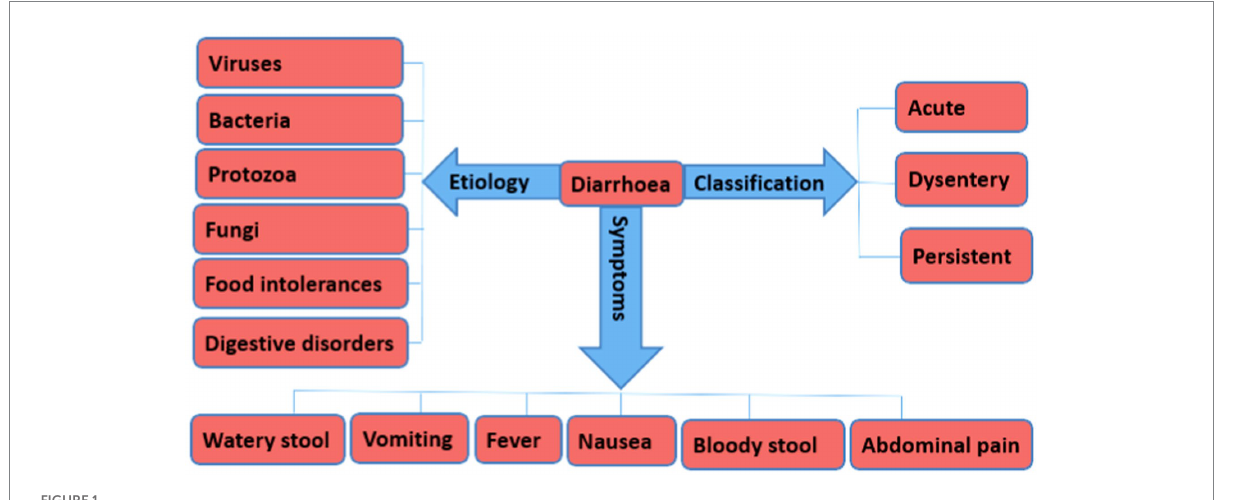
FIGURE 1 An overview of the different forms of Diarrhea, etiology, and symptoms.